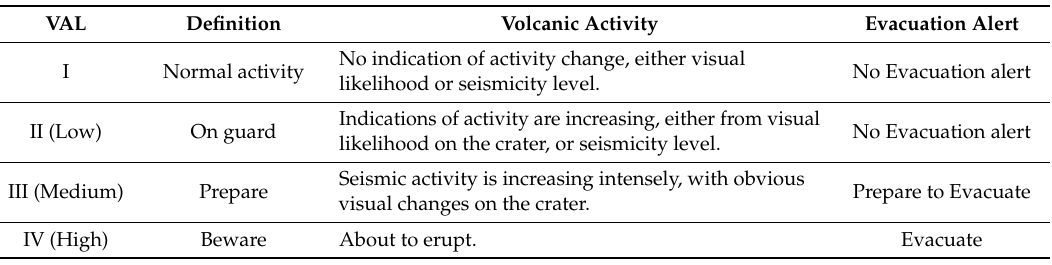
Table 5. Alert rules in